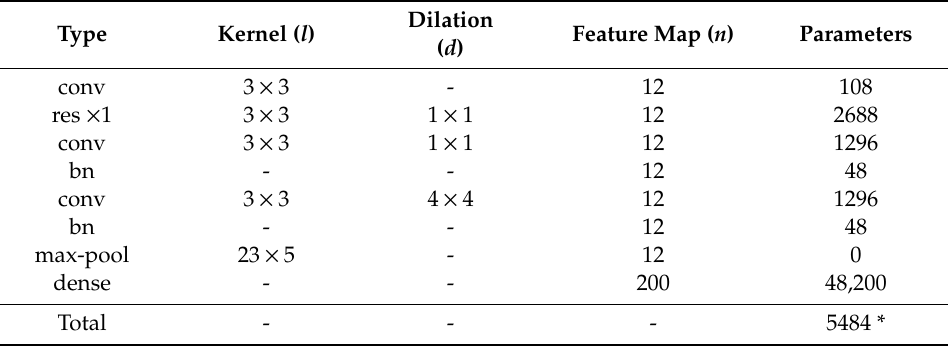
Table 1. Parameters used for the feature network of the proposed system. * The total number was calculated by excluding the 48,200 parameters of the dense layer, as the dense layer was excluded for the feature generation network of the actual